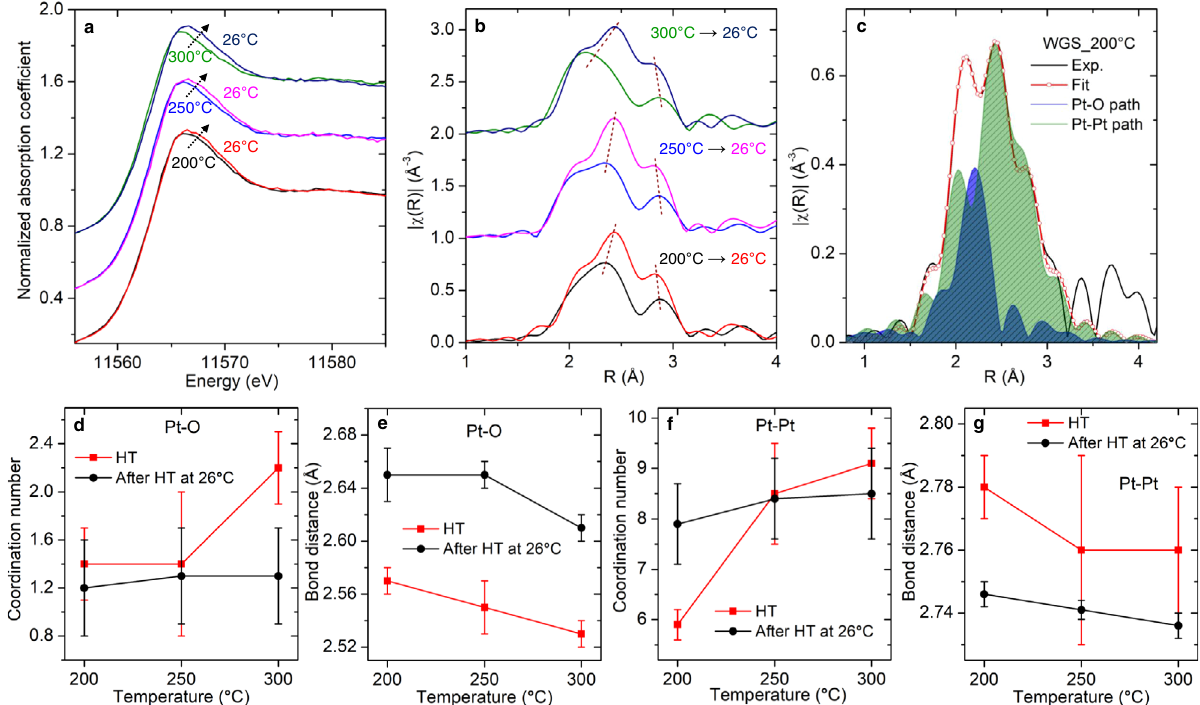
Fig. 6 XAS studies of working Pt nanocluster/CeO 2 for WGS reaction. a Normalized Pt L 3 XANES spectra and b Fourier transform magnitudes of k 2 χ (k) EXAFS spectra of Pt/CeO 2 under WGS condition at 200 °C, 250 °C, and 300 °C. For comparison, the RT spectrum was also collected after each measurement at high temperatures. Note that the spectra, for 250 °C and 300 °C, are shifted vertically by 0.4 and 0.8, respectively, in ( a ) and by 1.0 and 2.0, respectively, in ( b ) for clarity. c The representative fi gure shows the agreement between the experimental spectrum and the fi tted curve for the data collected in the WGS condition at 200 °C. The fi tting model includes two paths: Pt-O and Pt-Pt. The contribution of Pt-O and Pt-Pt path is also plotted for reference. The temperature-dependent change of d Pt-O coordination number, e Pt-O bond distance, f Pt-Pt coordination number, and g Pt-Pt bond distance under WGS conditions (red). For comparison, the results obtained for the spectrum collected at RT after each high temperature (HT) are also included (black). The error bars were obtained by performing analysis with IFEFFIT package 55 . The best- fi tting results are listed in Supplementary Table 2. The experimental and fi tted spectra are compared in Supplementary Fig. Active oxygen vacancies associate with perimeter Pt 0 sites . To Therefore, changes in Pt 2 + concentration indicates the quantify the ratio of perimeter Pt 0 /Ce 3 + , we carried out AP-XPS nanocluster-support interface restructures when cooled. Gen- measurements of the Pt 4 f and Ce 3 d regions under WGS con- erally, there is a higher fraction of Pt 0 than Pt 2 + at all tempera- ditions (Fig. 5 and Supplementary Fig. 7). Though XPS reveals the tures. Starting from about 65% Pt 0 and 35% Pt 2 + at 300 °C, the fraction of Pt 0 decreases linearly as the temperature decreases to effective valence state of Pt averaged over the entire nanocluster, positively charged Pt 2 + atoms (Supplementary Fig. 8), are most 200 °C, at which point the nanocluster contains approximately likely located at the interface with the Ce oxide support 35 . 55% Pt 0 and 45% Pt 2 + . This ratio is retained through further